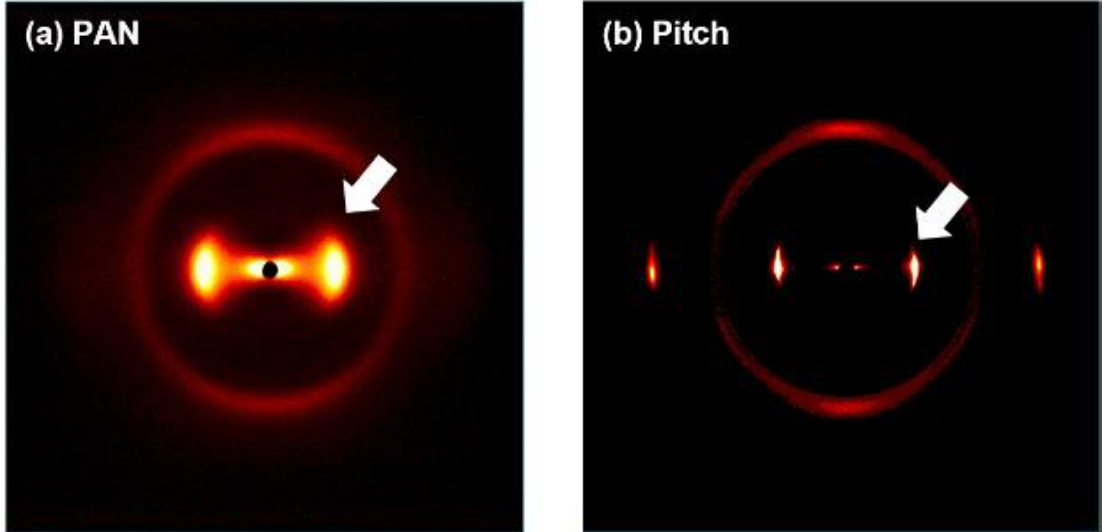
Figure 4. Wide-angle X-ray scattering (WAXS) for ( a ) PAN and ( b ) pitch-based carbon fiber. The white arrow is the location of the graphitic (002) peak around